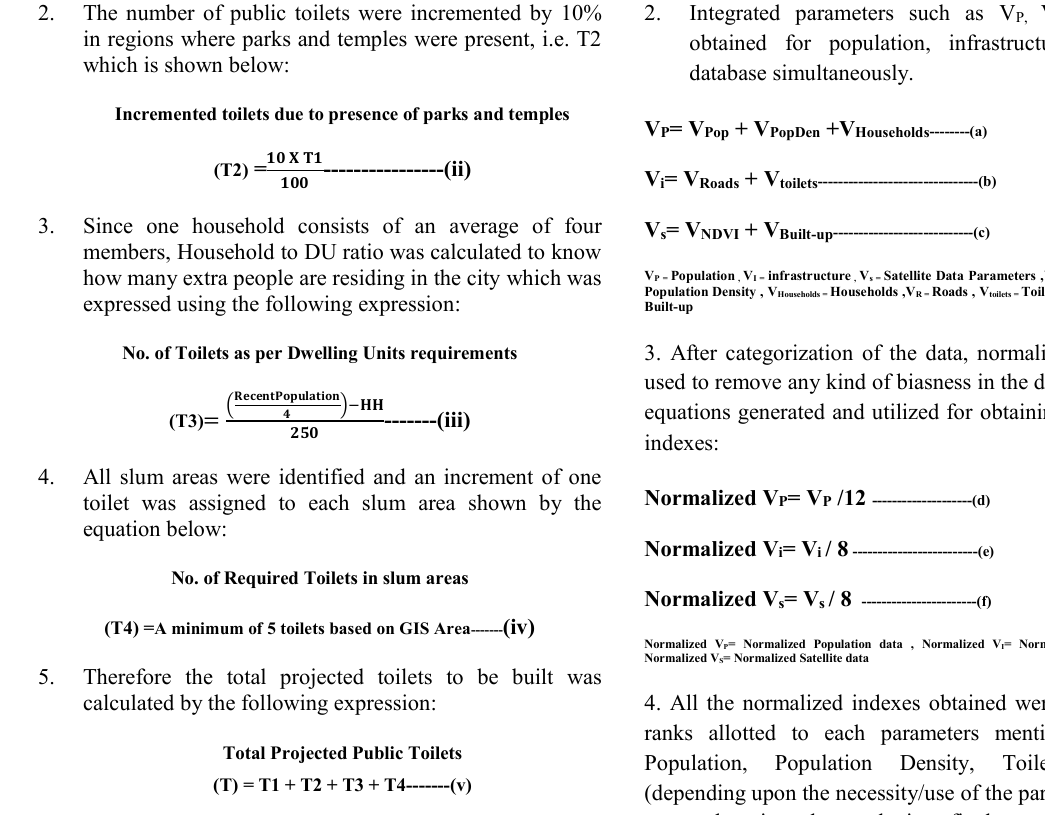
2. Integrated parameters such as V P, V i . and V s were obtained for population, infrastructure and satellite database